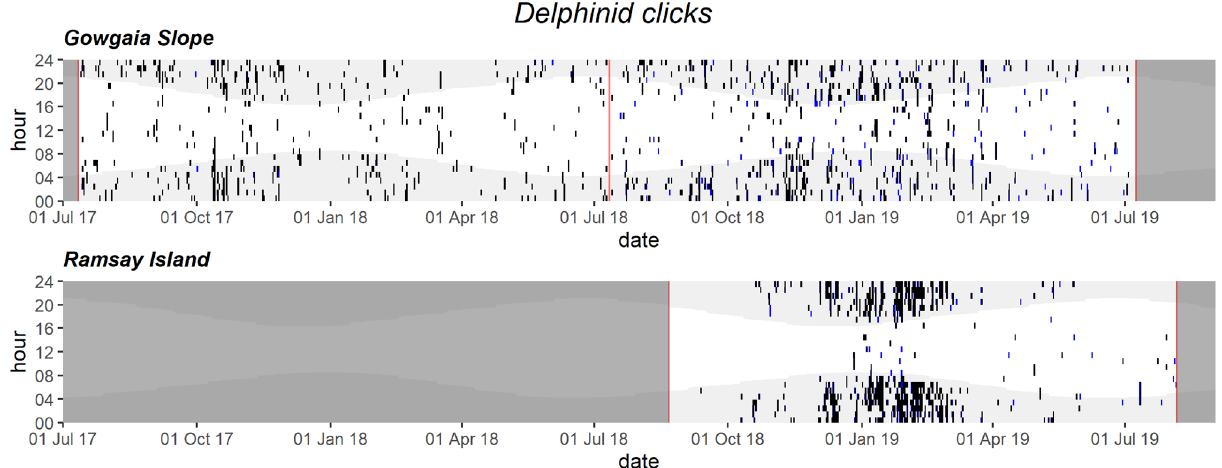
Figure 12. Daily and hourly occurrence of delphinid clicks at Gowgaia Slope and Ramsay Island in 1-h bins. Blue dots indicate automated detections. Black dots indicate confirmed occurrence. Red lines indicate recorder deployment and retrieval dates. Dark grey areas indicate a lack of recordings. Light grey shaded areas indicate hours of